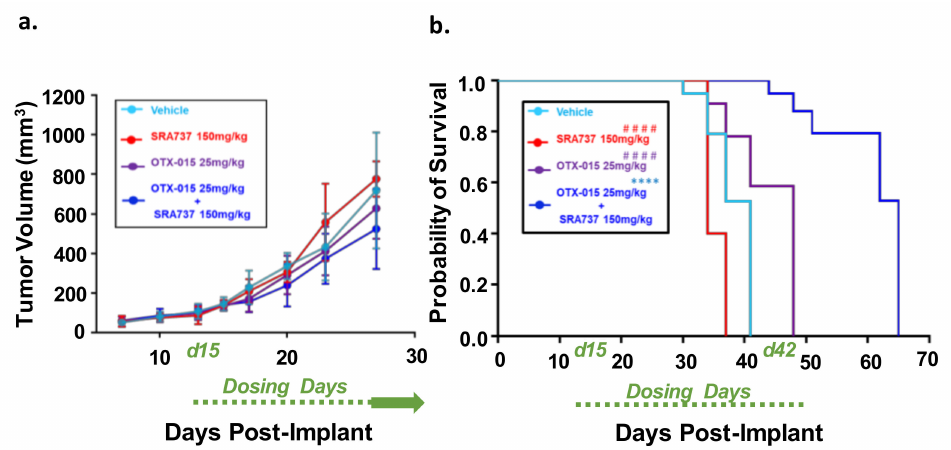
Figure 8. Combination therapy targeting BET and CHK1 increases the survival of mice with MYC-RAD21 + Saos2 CDX. ( a ) Tumor volumes are shown while all mice are still under study. Once tumor xenografts reached 100–200 mm 3 , mice were randomized and treated with four 5-day cycles of BETi / OTX-015 (25 mg / kg BID, days 1 through 5 of each cycle) and CHK1i / SRA737 (150 mg / kg SID, days 2 and 4 of each cycle) as single agents or as a combination, or the respective vehicle(s). There were n = 7 mice for the vehicle group and n = 4–5 mice for treatment groups. For cycles 1 and 2 of treatment, SRA737 was given 2 × / week and was well-tolerated. As previously mentioned, Saos2 is relatively resistant to SRA737 compared to other OS cell lines (Figure 4). Therefore, since the drug was well-tolerated in cycles 1 and 2, SRA737 doses were increased to 3 × / week in single-agent and combination treatment groups in cycles 3 and 4. Data represent tumor volumes when all mice were still under study. ( b ) Kaplan–Meier survival plot. An endpoint tumor volume of 1500 mm 3 was used for analysis. **** p < 0.0001 vs. vehicle; #### p < 0.0001 vs. BETi / OTX-015 + CHK1i / SRA737. Dosing